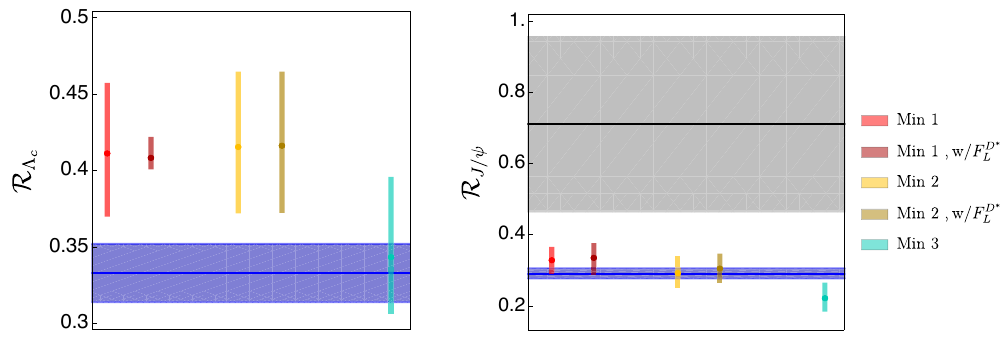
Figure 12 . Predictions for (left) and (right) for the minima of table 2 and table 3, with R Λ c R J/ψ τν ) 10%. The SM prediction is shown as a blue band. The experimental an upper bound ( B c → ≤ B is given by the gray value of R J/ψ